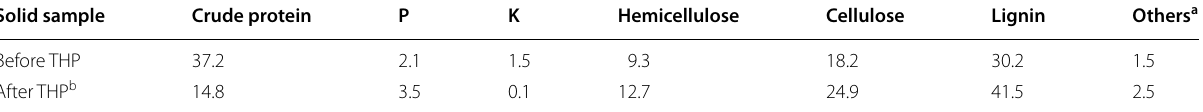
Table 1 Compositions of MDS samples before and the leftover solid after THP under THP II (wt%) Solid sample